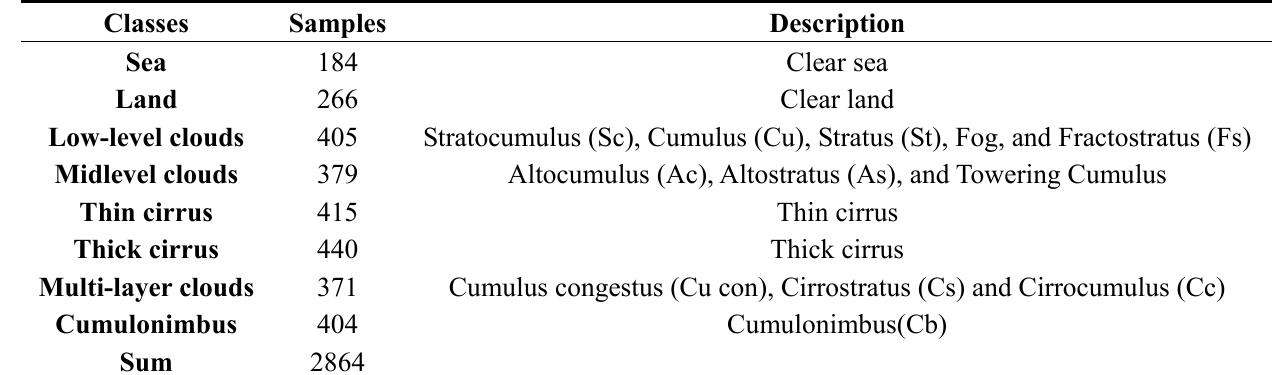
Table 2. The set of classes and samples in this